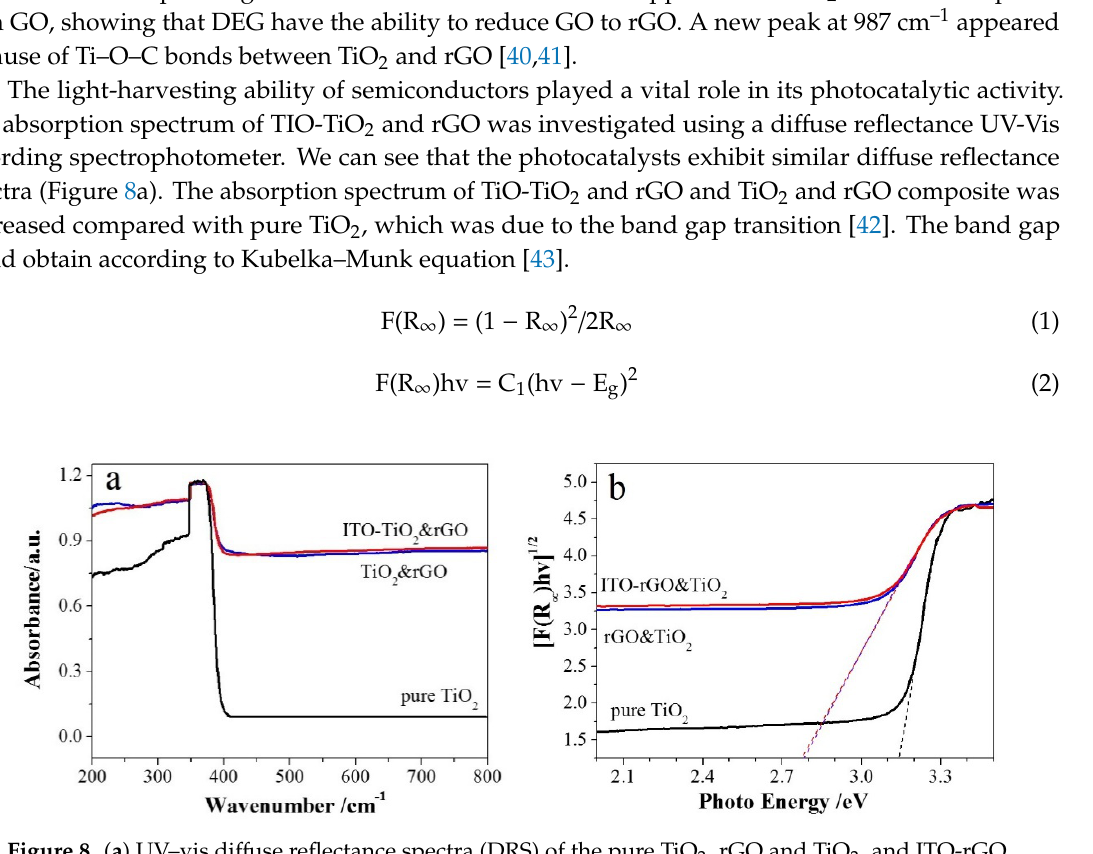
Figure 7. Raman spectra of ( a ) TiO 2 and ( b ) rGO.